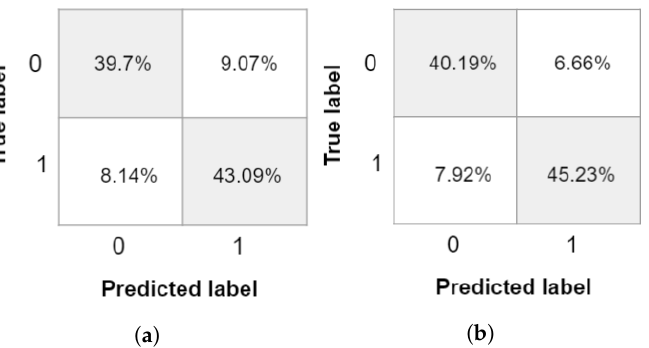
Figure 9. Confusion matrices of the test set, where label 0 represents background and label 1 means defect. ( a ) Confusion matrix of DeepLabV3+ trained only with real images and ( b ) confusion matrix of DeepLabV3+ trained with the original dataset augmented with synthetic images generated by the GAN with a 38% ratio.